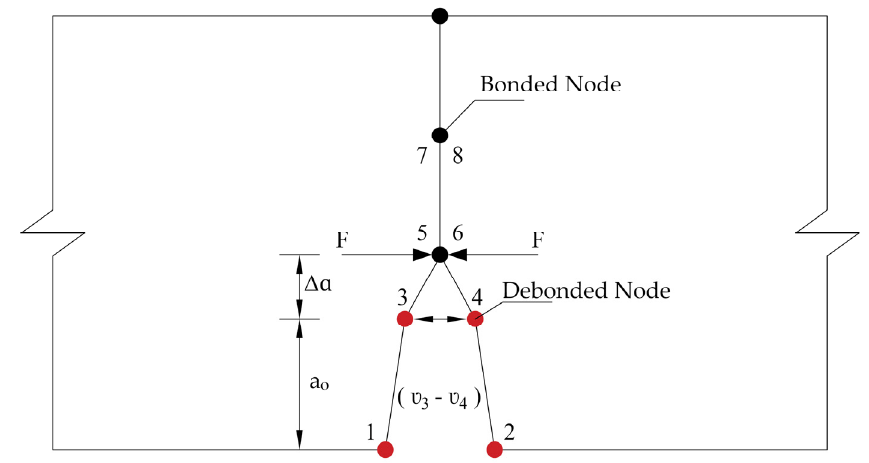
Figure 2. Virtual crack closure technique (VCCT) debonding at crack location.